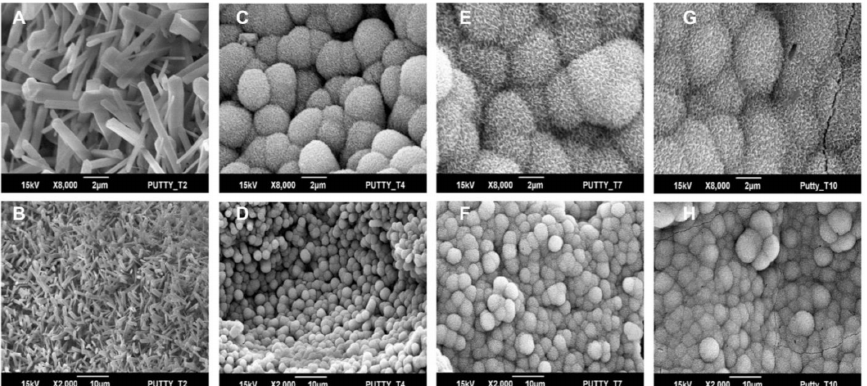
Figure 3. SEM images of surface mineralization on BCP-EP after ( A , B ) 2 days, ( C , D ) 4 days, ( E , F ) 7 days, and ( G , H ) 10 days immersion in SBF. Images were taken at 8000 × (top panel) and 2000 × (bottom panel) magnification. The needle-shaped surface topography at day 2 was identical to the baseline prior to immersion in SBF and identical to BCP granules prior to mixing with LEOL